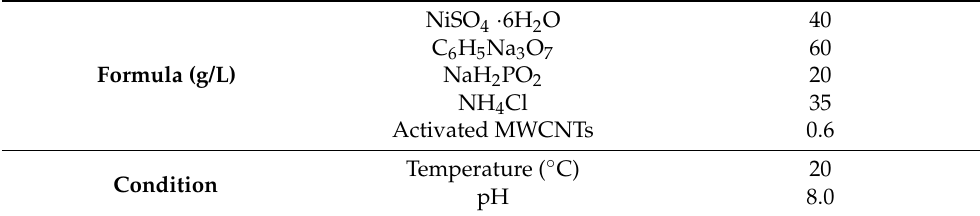
Table 1. Formula and conditions of electroless Ni plating.